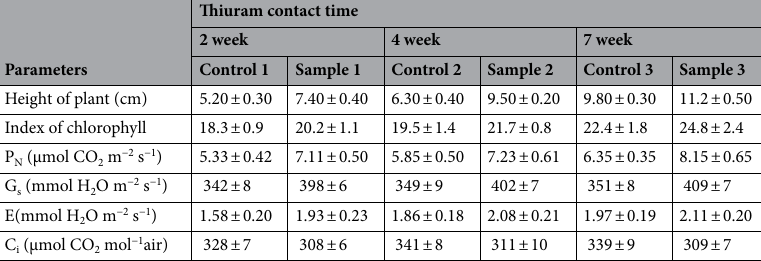
Table 4. The height of plant and photosynthesis indicators (mean ± SE, n = 5 ).